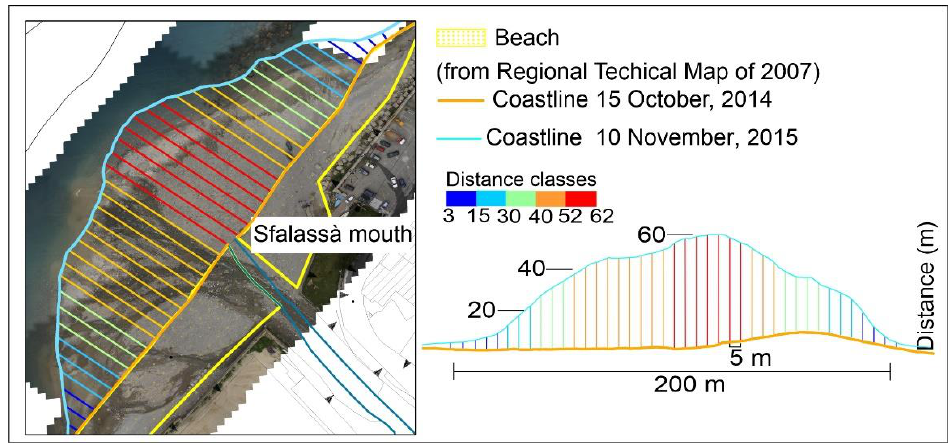
Figure 11. The extent of fan delta measured from the coastlines surveyed on 15 October 2014. Source: own elaboration overlaid to the Technical Map of Calabria Region.